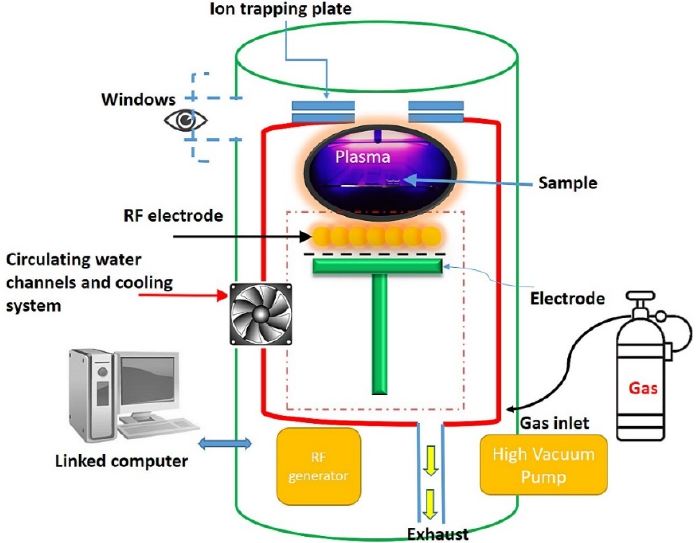
Figure 1. The schematic diagram of the H 2 O plasma treatment for PMMA and silicon bonding activation.